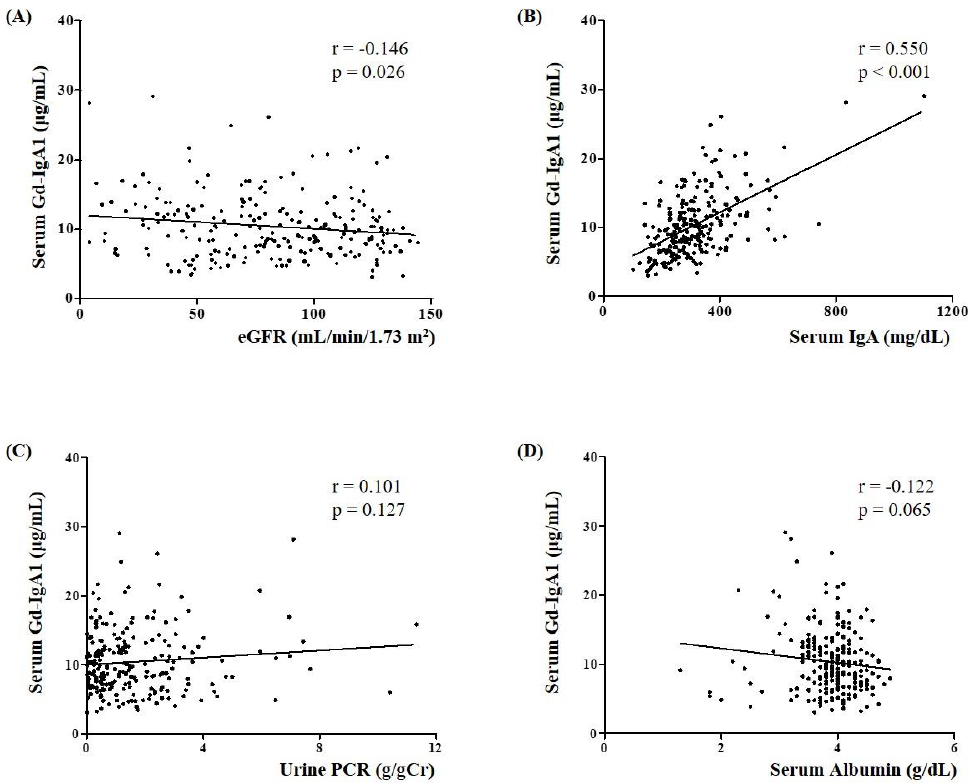
Figure 2. Relationship between serum Gd-IgA1 level and clinicopathological characteristics ( A : eGFR; B : serum IgA; C : urine PCR; and D : serum albumin) in patients with IgAN. Gd-IgA1, galactose-deficient IgA; IgAN, IgA nephropathy; eGFR, estimated glomerular filtration rate; PCR, protein to creatinine ratio. Data were statistically analyzed using Spearman’s rank correlation coefficient test. Table 2. Serum Gd-IgA1 levels according to pathologic findings based on the Oxford classification (MEST-C).